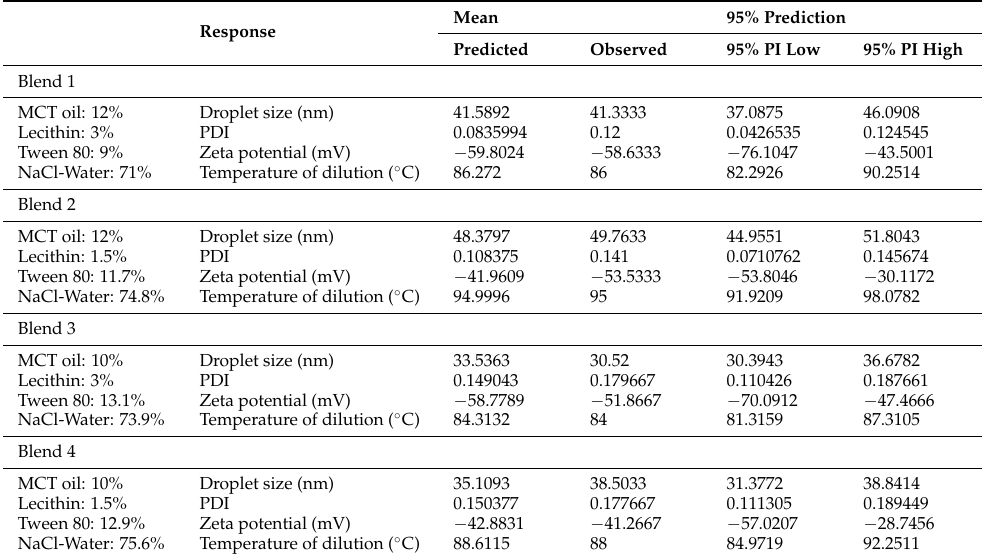
Table 8. Observed means against the prediction